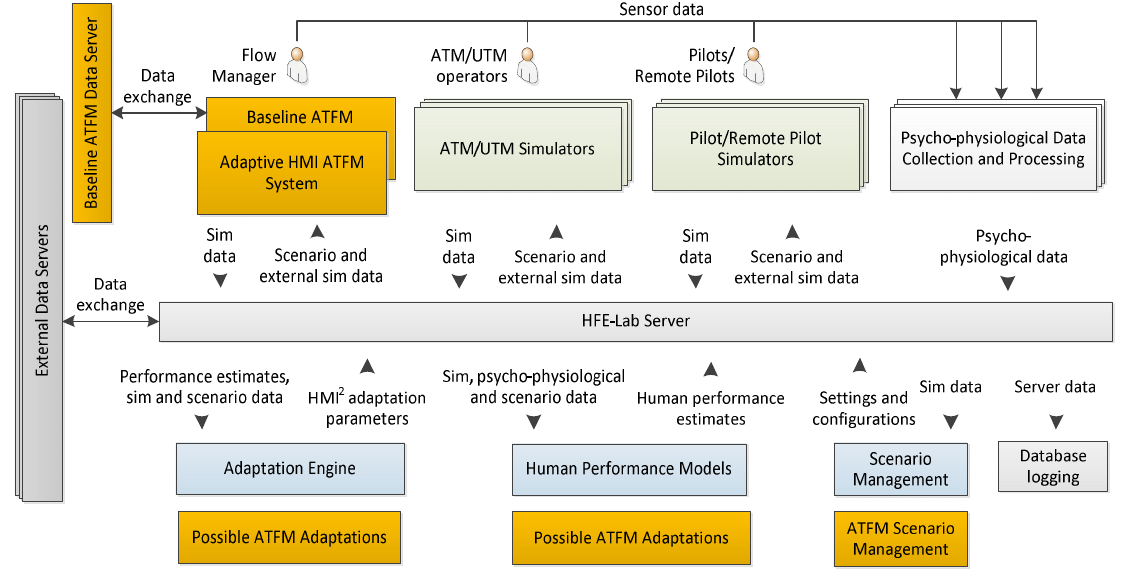
Figure 3. Architecture of the Royal Melbourne Institute of Technology (RMIT) air traffic management (ATM) laboratory (adapted from Reference [36]).